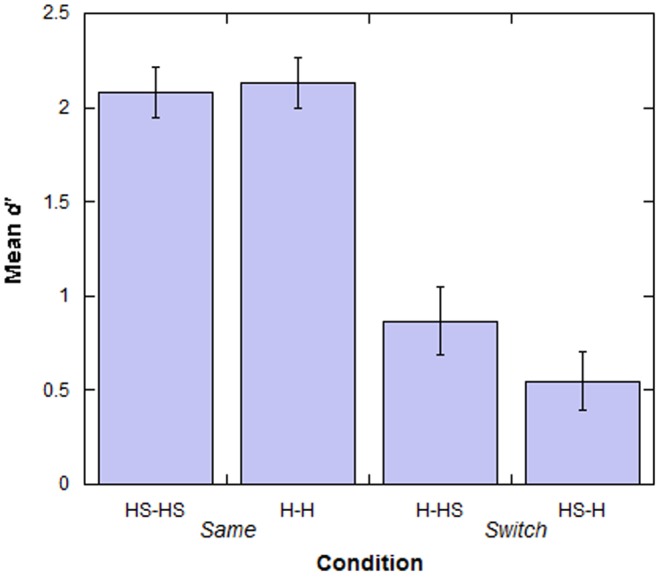
Performance levels in the Same and Switch conditions for Experiment 1 split by the type of trial in each condition.Error bars represent Standard Error. HS-H, (for example), refers to those trials in which the faces that were presented as HS faces in the learning stage were switched and presented with H in the test stage.